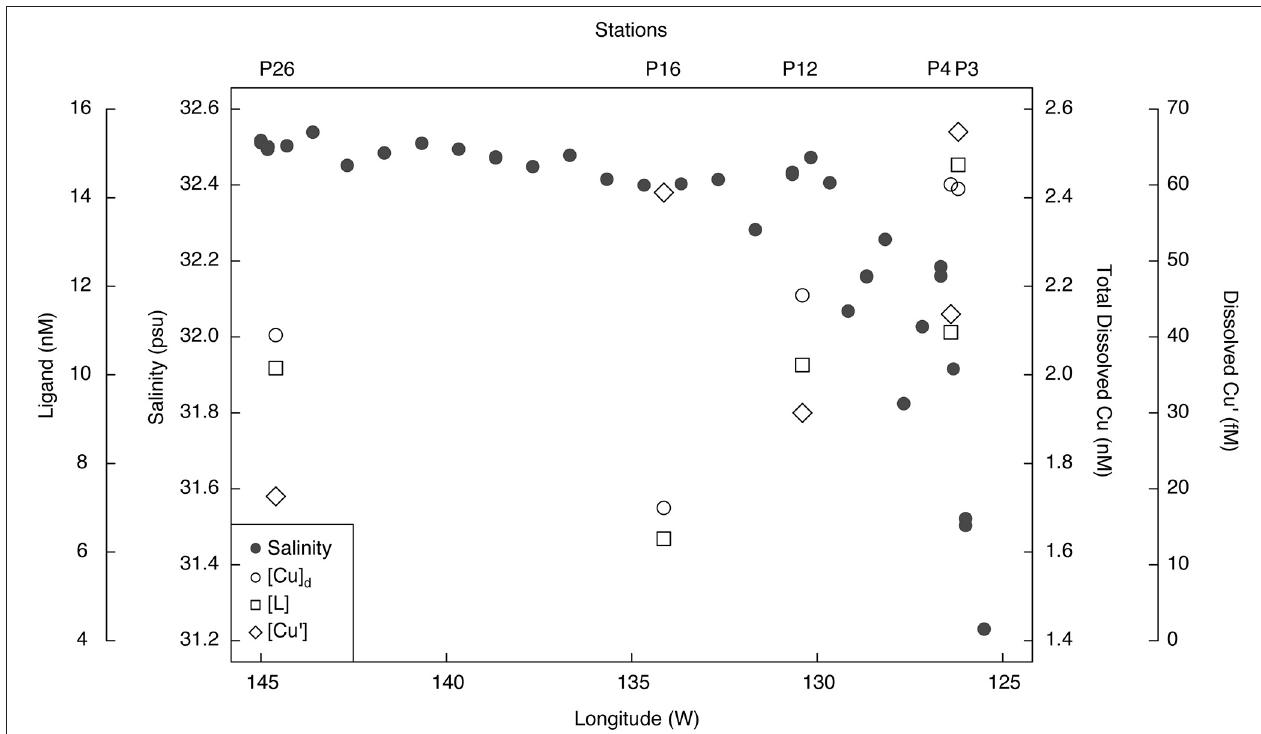
FIGURE 3 | Surface salinity, total dissolved Cu (nM), Cu-binding ligands (nM), and inorganic Cu (fM) concentrations along the Line P transect. Salinity was sampled at 5m using the ship’s internal seawater pumping system, while the Cu concentration and speciation samples were from the shallowest depths sampled along the transect (7–10 m; Table 2